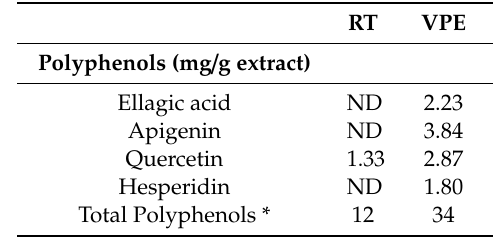
Table 1. Major phenolic constituents of vine pruning residue extracts obtained by two di ff erent extraction methods: at room temperature (RT) and by ohmic heating (vine pruning residue